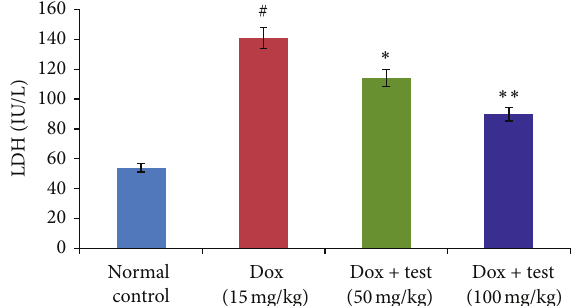
Figure 2: Effect of test compound on plasma LDH levels in rats treated with doxorubicin. # 𝑃 < 0.001 versus normal control; ∗ 𝑃 < 0.05 ; ∗∗ 𝑃 < 0.01 versus dox.